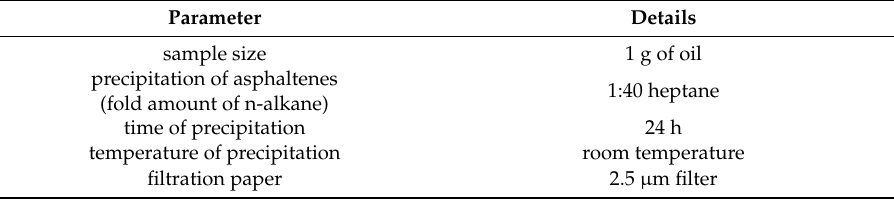
Table 3. The analytical parameters, tools, and separation conditions for conducting SARA